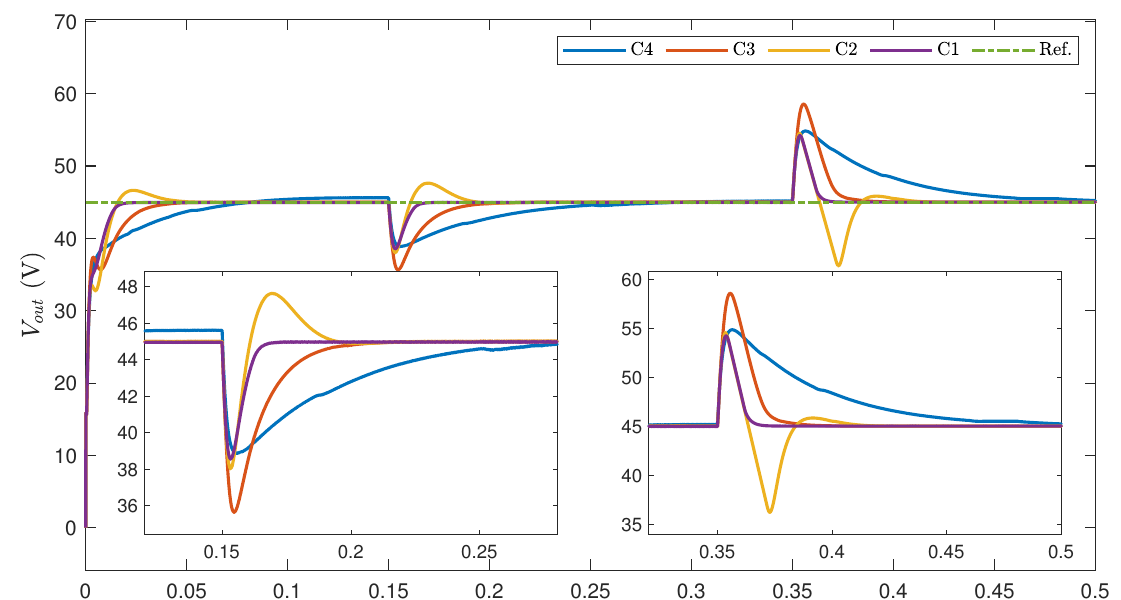
Figure 5. The output voltage of the FIBC under the four controllers in the case of step load